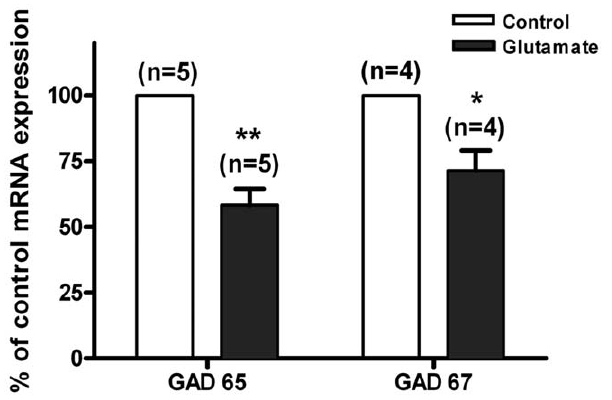
Figure 3. Glutamate excitotoxicity decreases GAD65/67 mRNA. Gene expression was analysed in cultured hippocampal neurons (7 DIV) exposed or not to 125 m M Glutamate, for 20 min, and then returned to the original culture medium for 4 h. For the reverse transcription reaction 1 m g of total RNA was used. The results were normalized with two internal control genes, GAPDH and Tubulin. Data are presented as mean 6 SEM of four to five independent transcription reactions, performed in independent preparations. Statistical analysis was performed using Student’s t -test. * p , 0.05; ** p , 0.01.